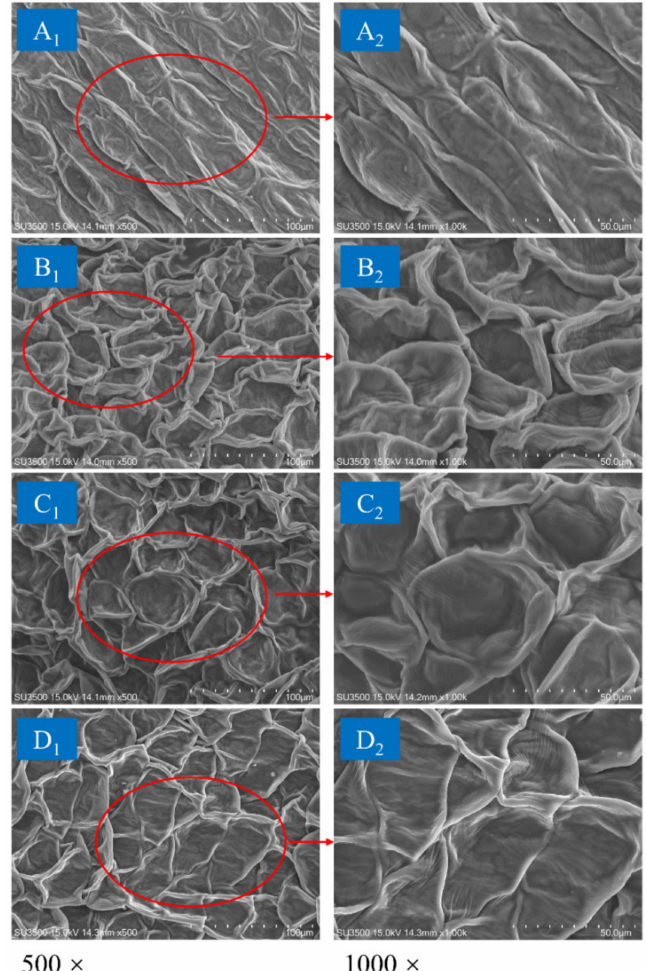
Figure 10. Scanning electron microscope images of dried chrysanthemum at 65 ◦ C by different drying methods: ( A ): freezing drying; ( B ) hot air drying (HAD); ( C ) combined infrared and hot air drying (IR-HAD); ( D ): sequential IR-HAD and HAD (IR-HAD +